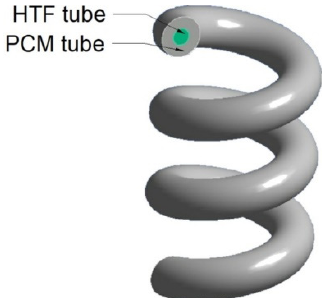
Figure 8. The double-tube helical-coil HX [81].